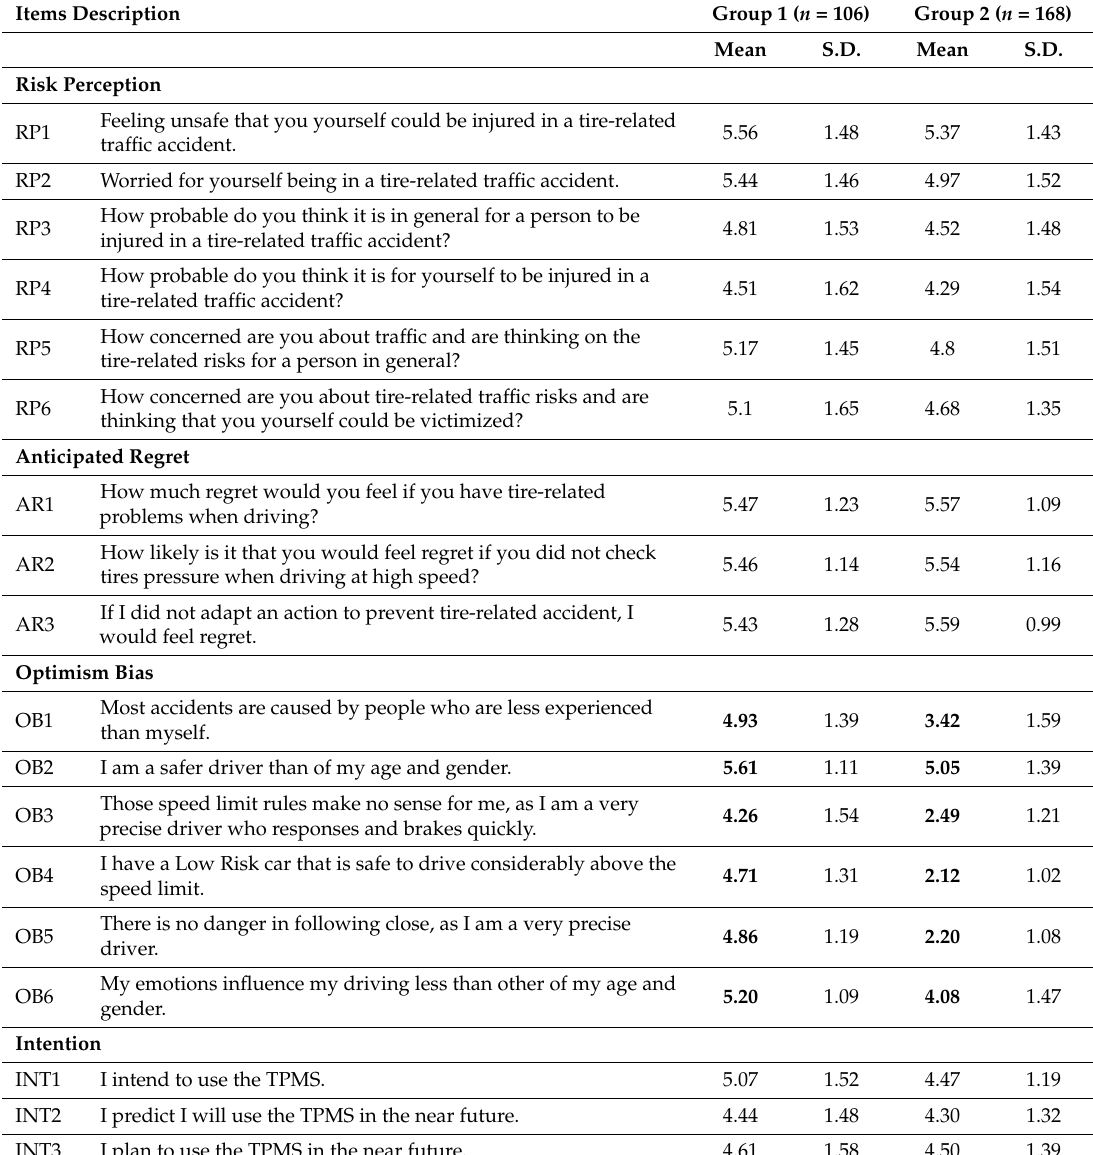
Table 5. Table highlighting responses to personal optimism bias